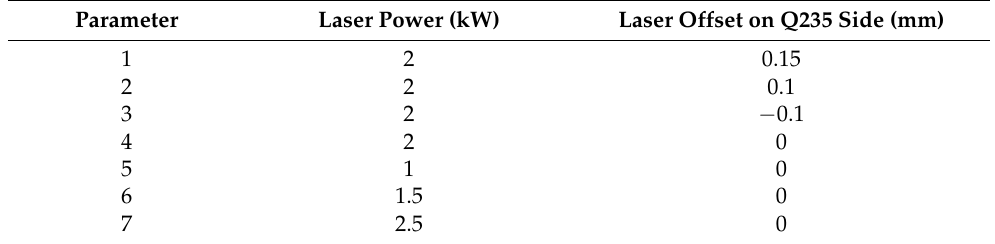
Table 1. The process parameters of the laser butt welding of AISI 304L and Q235 steels. Parameter